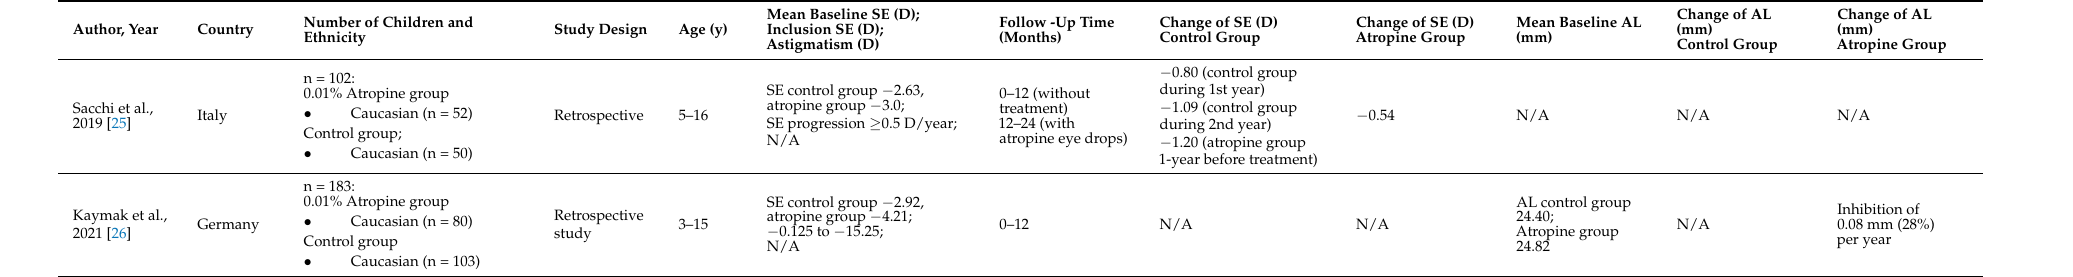
Table 3. Characteristics of retrospective studies included in the